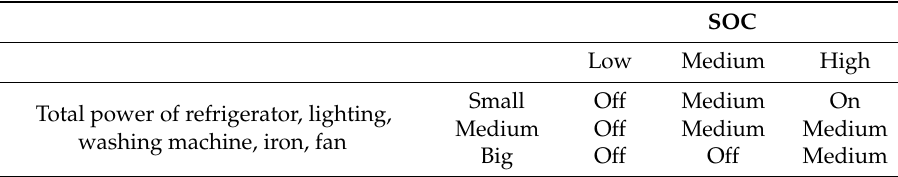
Table 3. Fuzzy rules of